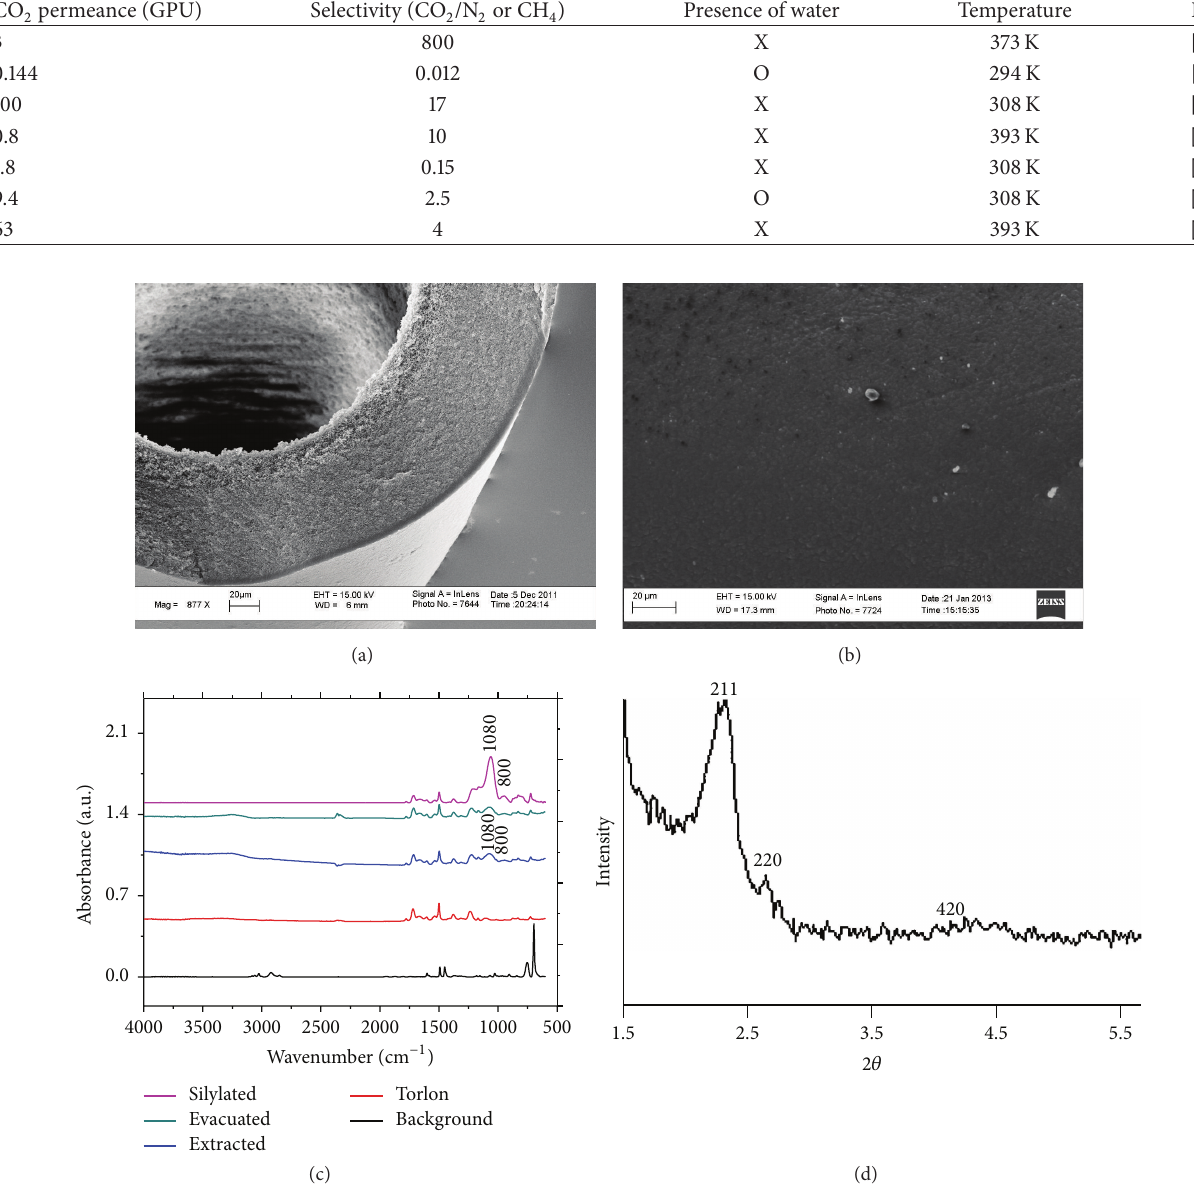
Figure 6: Characterization of modified mesoporous silica membranes. SEM images of the (a) cross section and (b) top view of an aziridine- functionalized mesoporous silica membrane [48], (c) FT-IR/ATR spectra for a silylated mesoporous silica membrane [53], and (d) XRD pattern of a PEI-modified MCM-48 membrane